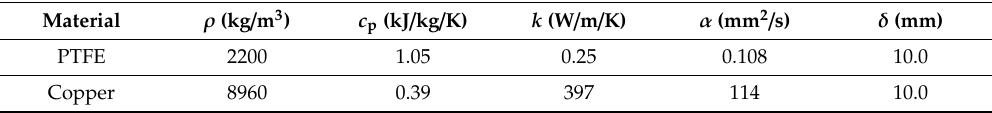
Table 2. Properties of Polytetrafluoroethylene (PTFE) and copper substrates as density ρ (kg / m 3 ); specific heat capacity c p (kJ / kg / K); thermal conductivity k (W / m / K); thermal di ff usivity α (m 2 / s), α = k / ρ c p ; and thickness δ (mm) at 20 °C and 1 atm. We state here that thermal diffusivities α in this table are the right values compared to the values earlier reported [4,18].